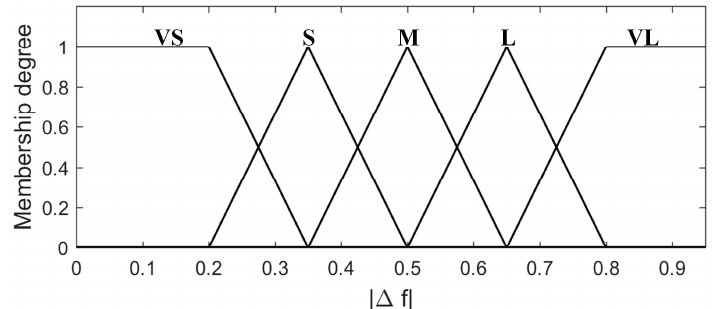
Energies 2019 , 12 , x FOR PEER REVIEW Figure 3. Membership function (changing in grid’s frequency). Figure 3. Membership function (changing in grid’s frequency).